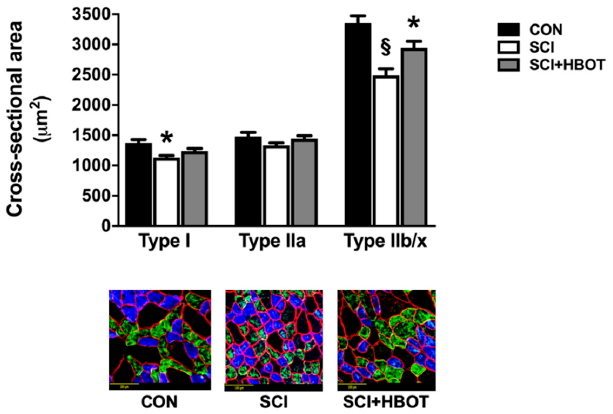
Figure 2. Diaphragm muscle cross-sectional area and fiber typing. Representative fluorescent staining of myosin heavy chain (MHC) I (type I) (DAPI filter/blue), MHC IIa (type IIa) (FITC filter/green), MHC IIb/IIx (type IIb/x) (non-stained) and dystrophin (Rhodamine filter/red) proteins in diaphragm samples are shown below the graph. Scale bar = 100 μ m. Values are mean ± SEM. § Significantly different versus all groups ( p < 0.05). * Significantly different versus CON group ( p < 0.05). CON—